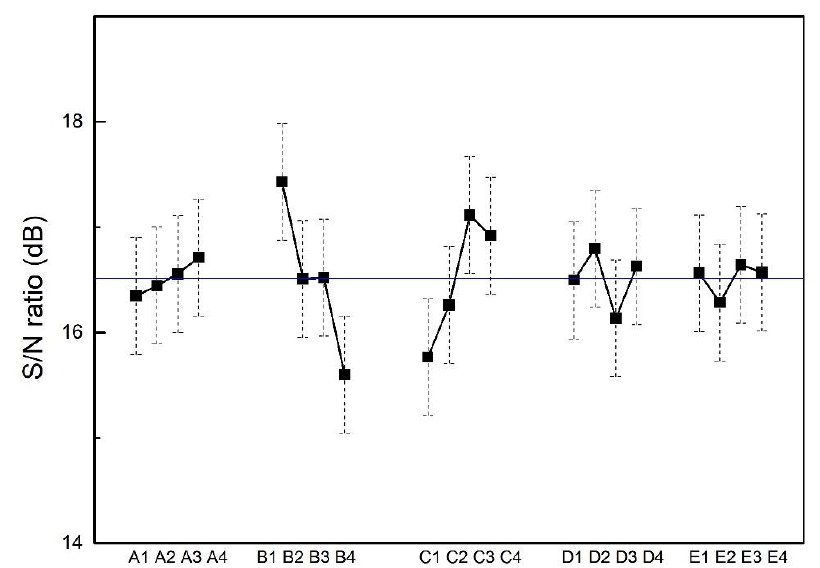
Figure 11. Taguchi analysis plot for film hardness, where the experimental factors (A, B, C, D and E) and levels (1, 2, 3 and 4) can be found in Table 1. The horizontal line across the figure represents the mean S/N ratio of the 16 trials.